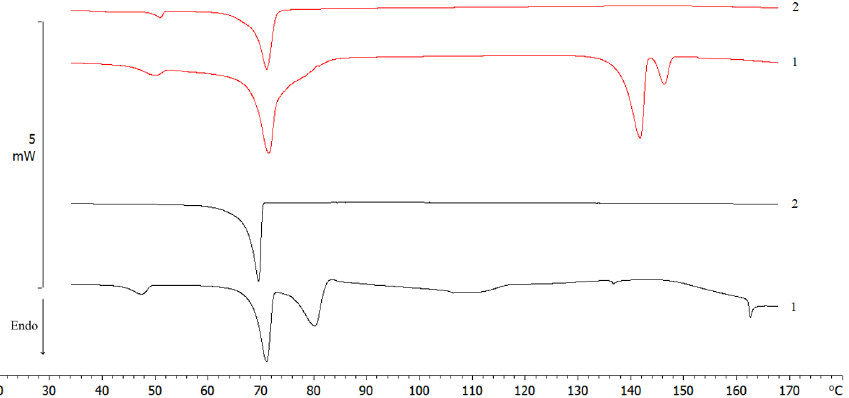
Figure 5. DSC thermograms of G 1 lyophilized SLN using the technique of inverted lid (black) or pierced lid (red) technique. Table 3. Enthalpy variations ( H) and peak temperatures of the first scan and second scan of G 1 lyophilized SLN obtained through inverted lid and pierced lid procedures.